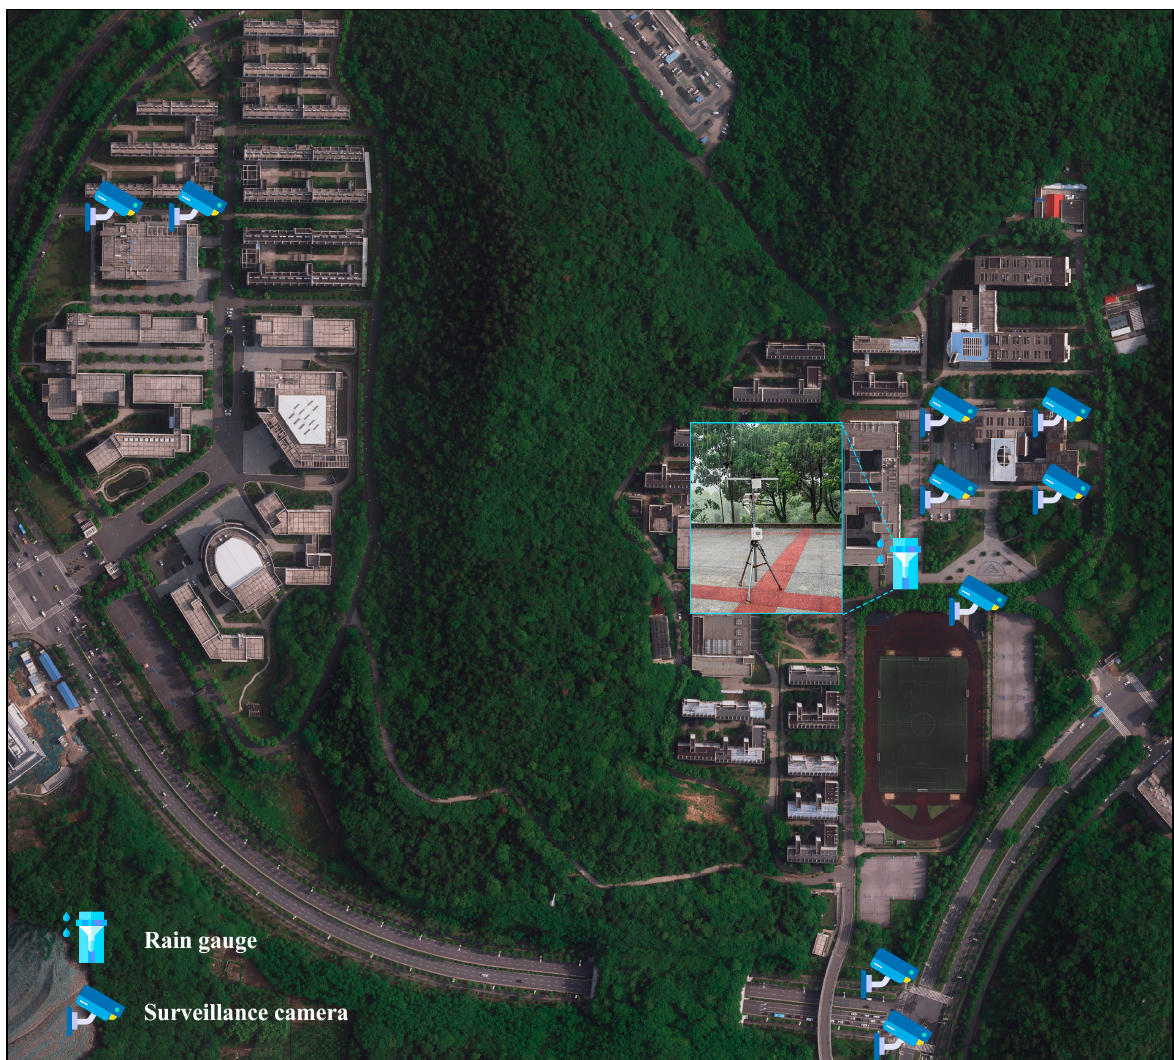
Figure 5. Locations of some of the surveillance cameras at Nanjing Normal University.